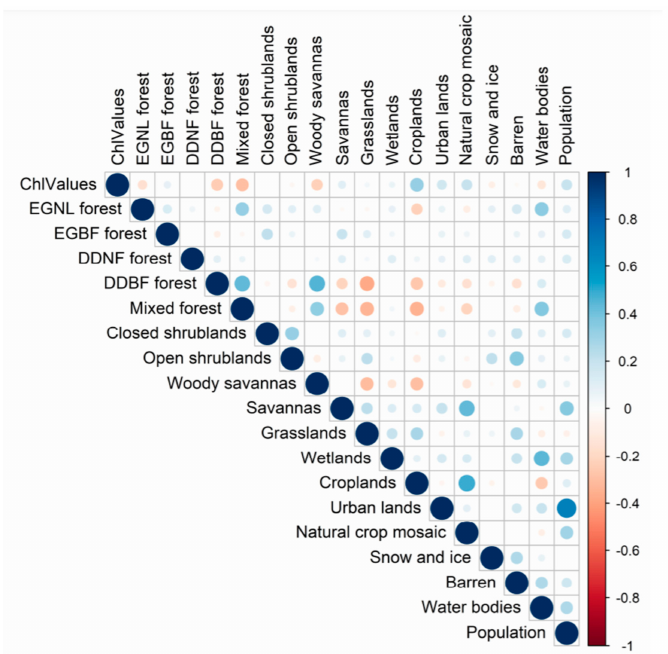
Figure 3. Spearman correlations between chlorophyll concentrations, land cover categories and human population within the pseudo-watersheds of 9313 lakes. Blue circles indicate positive correlations, red circles indicate negative correlations. Absent circles indicates insignificant correlation ( p > 0.05). The acronyms are as follows: DDBF = Deciduous Broadleaf, EGBF = Evergreen Broadleaf, DDNF = Deciduous Needleleaf, EGNL = Evergreen